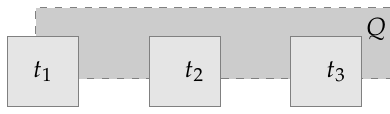
Figure 7. C-FLAT multi-core